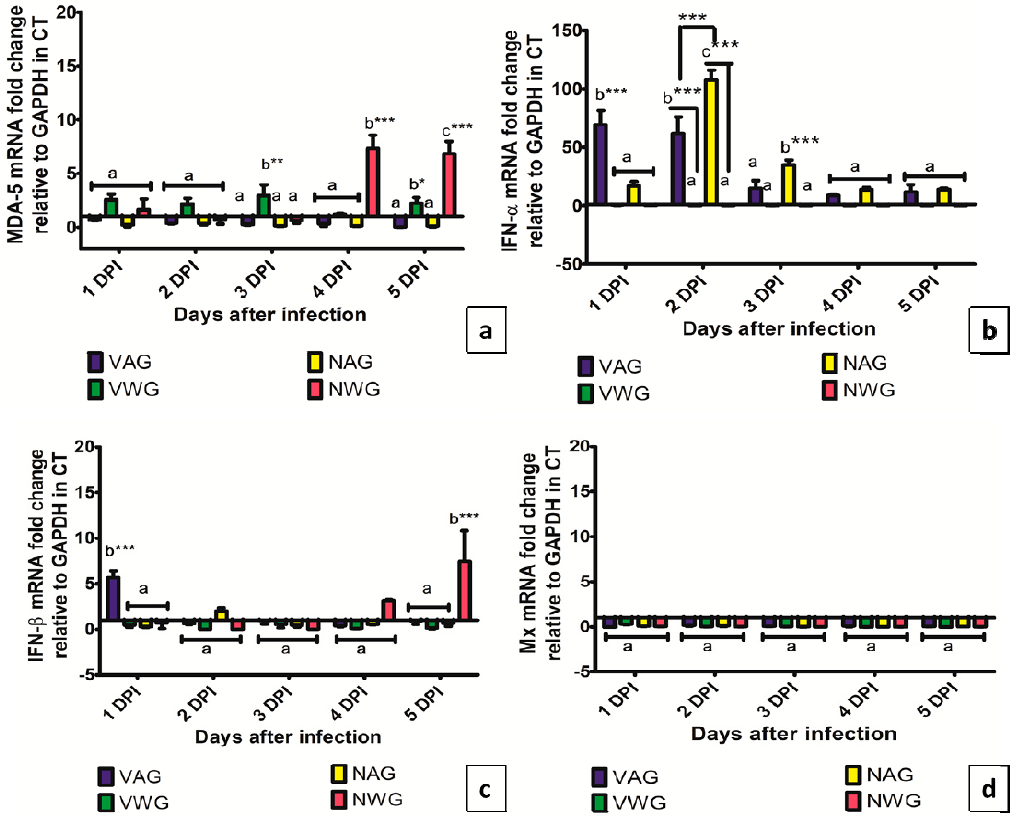
Figure 6. Expression of ( a ) MDA-5 ( b ) IFN- α ( c ) IFN- β ( d ) Mx. genes in Caecal tonsil of vaccinated and Non-vaccinated Aseel and White Leghorn chicken infected with very virulent IBDV. The groups were as follows: VAG-Vaccinated Aseel Group; VWG-Vaccinated White Leghorn group; NAG-Non-vaccinated Aseel Group; NWG- Non-vaccinated White Leghorn Group. Error bars represent standard error of the mean. Relative changes in the expression of genes were quantified by real-time PCR by comparison with expression levels of the housekeeping gene GAPDH and expressed as the fold-change. The value of 1.00 was kept as the control and the fold change values which were above the control values were considered as significant. *significant difference comparing VAG with VWG and NAG with NWG chickens of the same line at the same point where P < 0.05*, P < 0.01**, P < 0.001***. ( a - c ): Experimental groups sharing common lowercase superscript letters are statistically non-significant for each observation day.